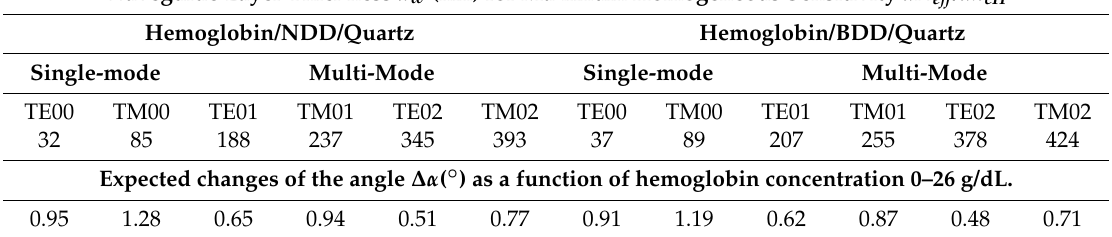
Table 3. Analysis of maximum homogeneous sensitivity d Neff /dn cH , changes of the angle ∆ α as a function of different hemoglobin concentration (Figure